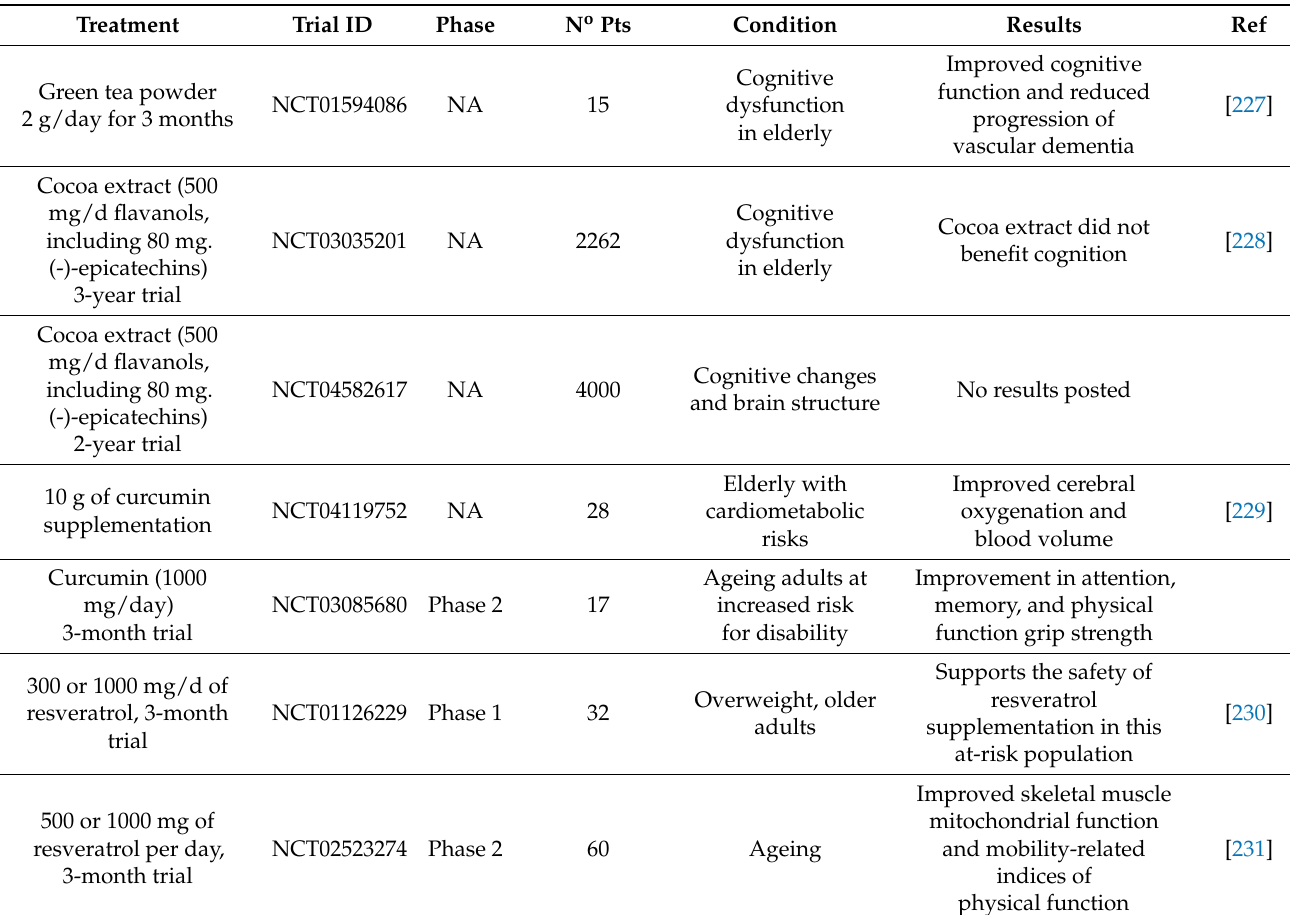
Table 2. Completed clinical trials evaluating the effects of selected polyphenols on